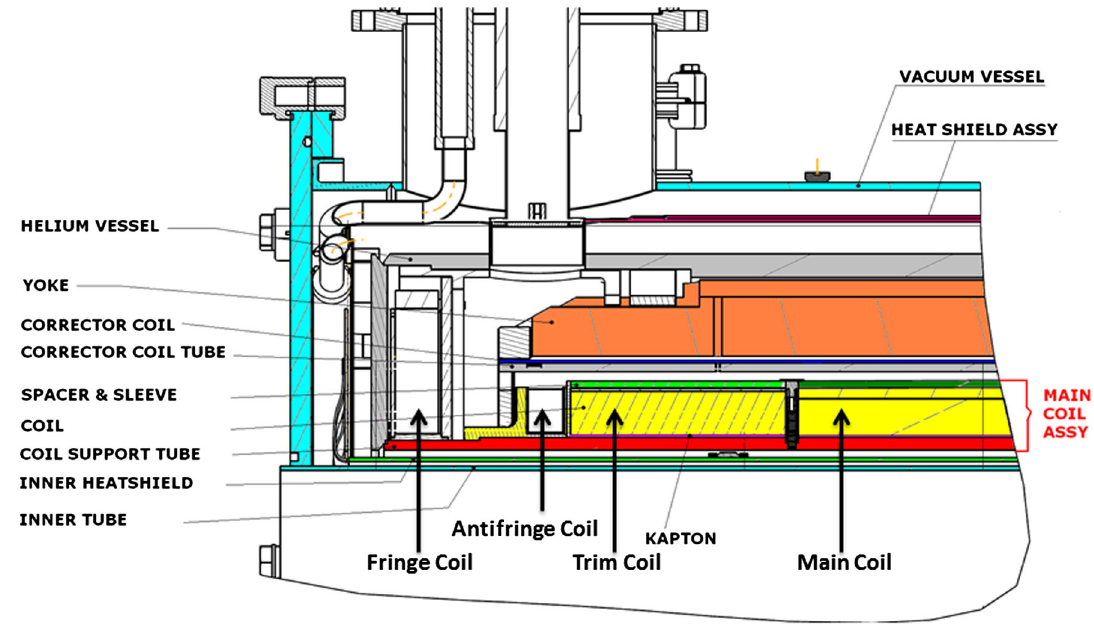
FIG. 8. Cross section of the RHIC electron lens superconducting